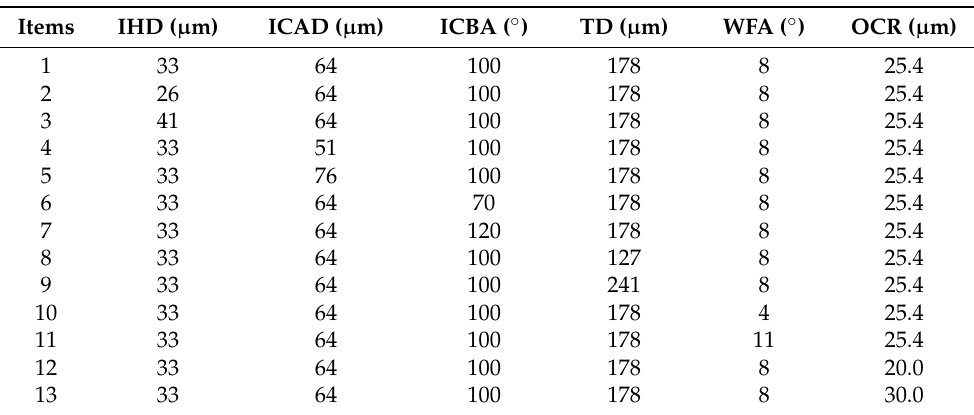
Table 2. Ceramic capillary geometric parameter